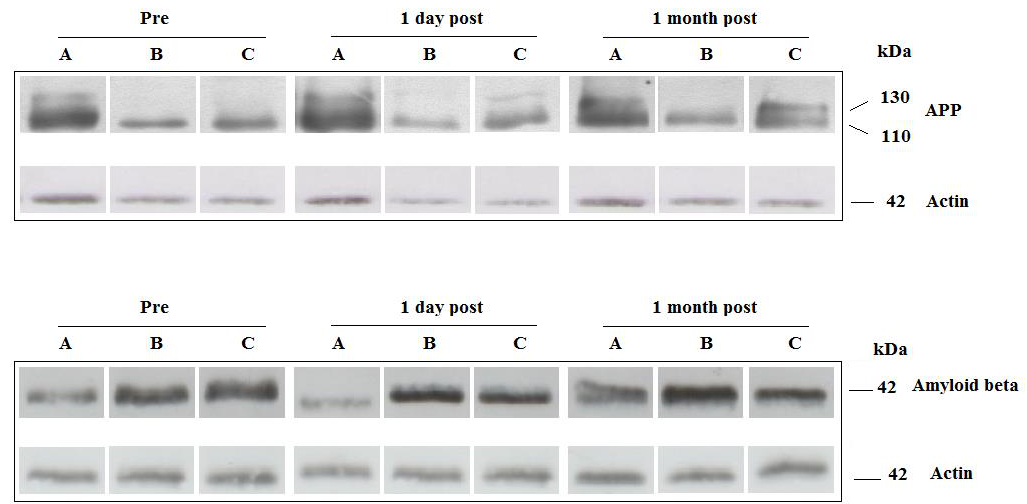
Pre-baseline; ˆ p < 0.05 versus MCI + Sham group.